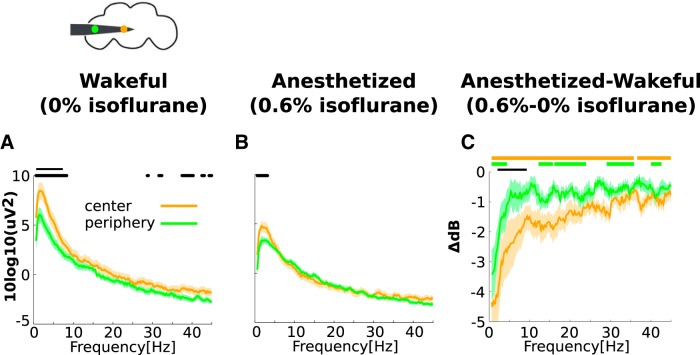
Isoflurane reduces power in the center and periphery. A, Group average power in the center (orange) and periphery (green) in 0% isoflurane (before any anesthesia). A schematic representation of the fly head and inserted electrode showing the estimated positions of one central (orange) and one peripheral (green) channel is depicted above. Black dots and solid line mark uncorrected and corrected significant differences between center and periphery power at the p < 0.05 level, respectively (see Materials and Methods). B, Same as A in 0.6% isoflurane. C, The effect of isoflurane on power in the center and periphery, obtained by subtracting values in 0% isoflurane from values in 0.6% isoflurane. Negative values indicate that isoflurane reduced power for both the center and periphery. For central channels, orange thick lines above indicate significant reductions due to isoflurane (corrected, p < 0.05). For peripheral channels, green thick lines above indicate corresponding significant reductions (corrected, p < 0.05). Greater reductions in power in the center compared to the periphery are indicated by the black line (corrected, p < 0.05). Shaded area represents SEM across flies (N = 13) for all panels.